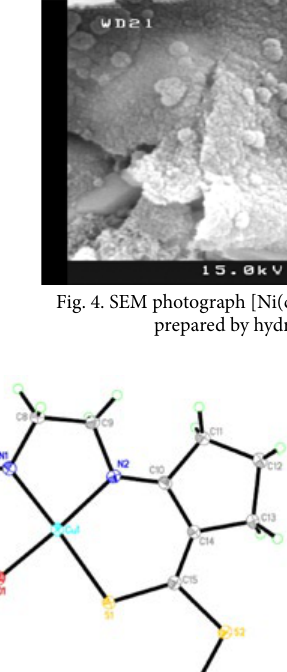
Fig. 5. ORTEP diagram and atom numbering scheme for the complex [Cu(cdClsalen)] with 50% probability ellipsoid for the non-hydrogen atom.